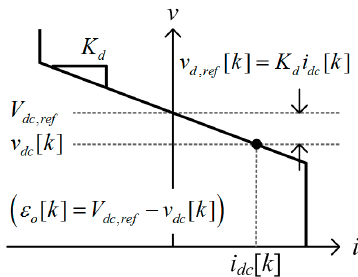
Figure 7. Voltage-loop reference on V – I curve of GC local controller.